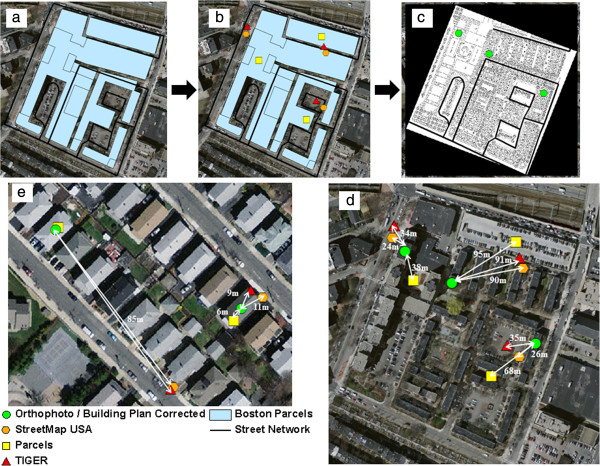
Example for ascertaining true ground location and determining positional error for large multi-building parcels and single/multi-family home (i.e. duplexes and triple-deckers). a. Example of a large multi-building parcel with both senior and affordable housing units comprised of 15 different parcels, b. Three different addresses have been geocoded to both street-networks (red triangles & orange hexagons) and parcels (yellow squares), c. Building location with unit layouts are georeferenced in ArcGIS using ortho-photos to ascertain true location (green circles), d. Distance between Street-network, parcel and the corresponding true ground location determined through building and unit master plans for large multi-building parcels, e. Distance between Street-network, parcel and the corresponding ortho-photo corrected to the middle of the home for large multi-building parcels.